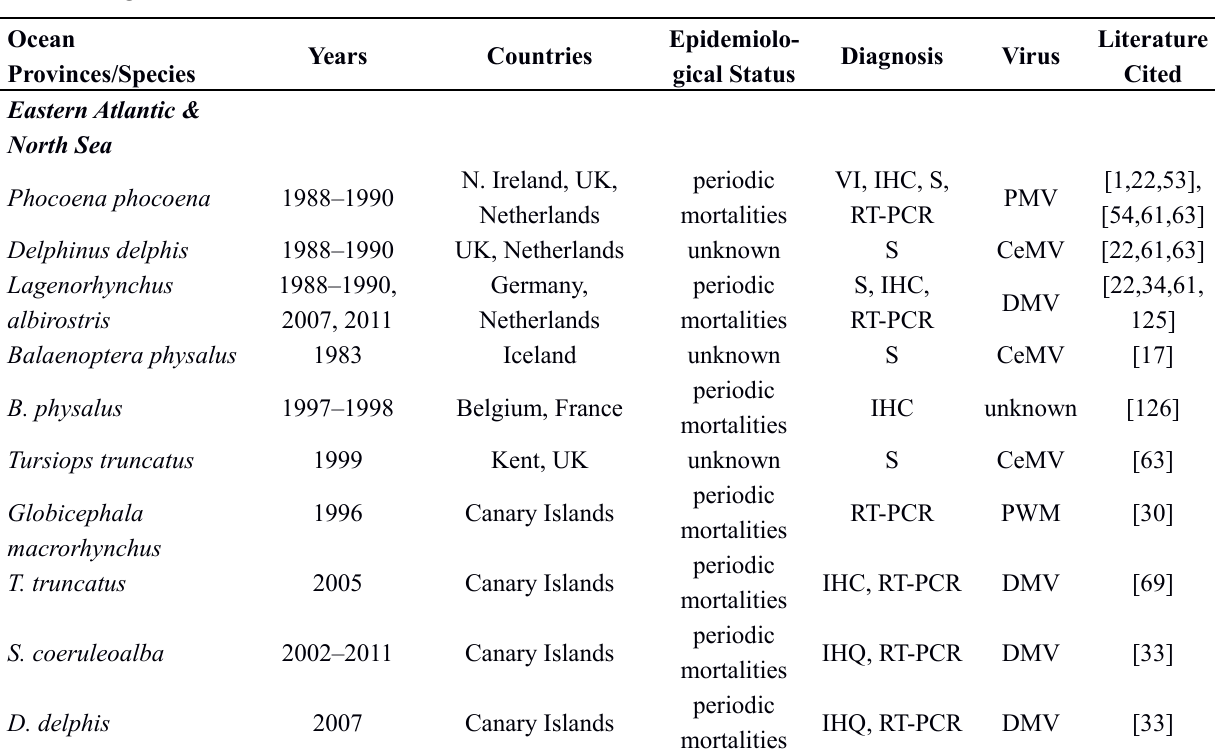
Table 1. CeMV infection in odontocetes and mysticetes worldwide. Abbreviations are: VI = virus isolation, IHC = immunohistochemistry, S = serology, RT-PCR = reverse-transcriptase polymerase chain reaction, PMV = porpoise morbillivirus, CeMV = cetacean morbillivirus, DMV = dolphin morbillivirus, PWMV = pilot whale morbillivirus and CeMV, NL = new lineage of